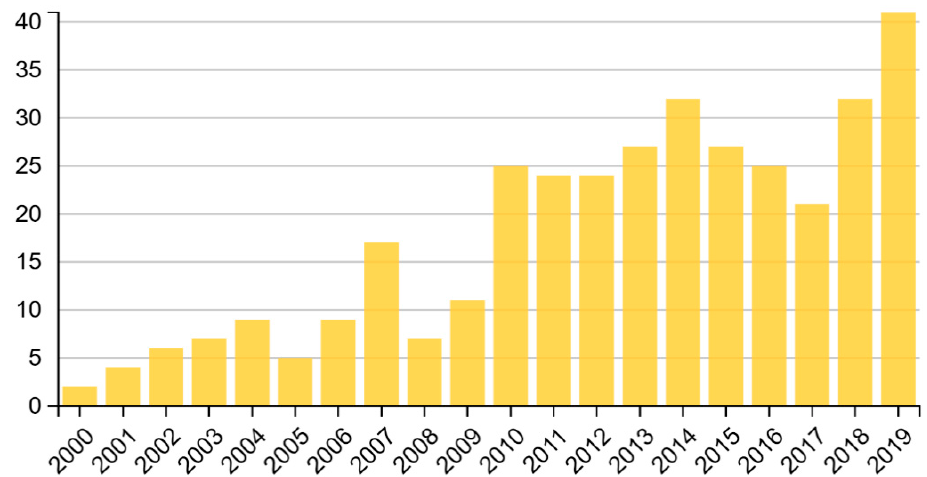
Figure 2. Patent application activity for the last 20 years in the Czech Republic in the medical devices sector.